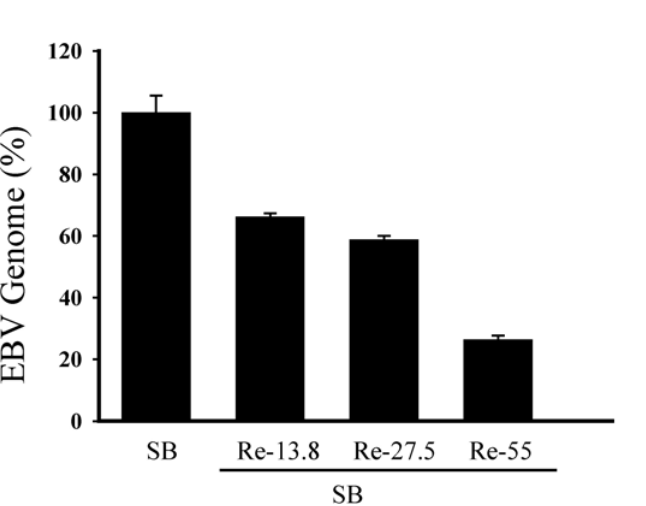
Figure 5. Resveratrol treatment and production of EBV